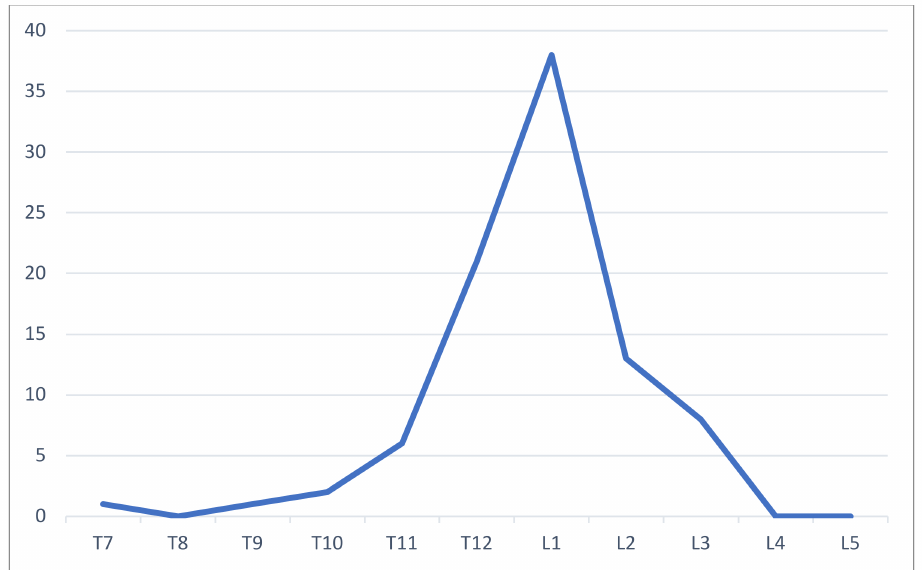
Figure 3. Fracture distribution along the spine